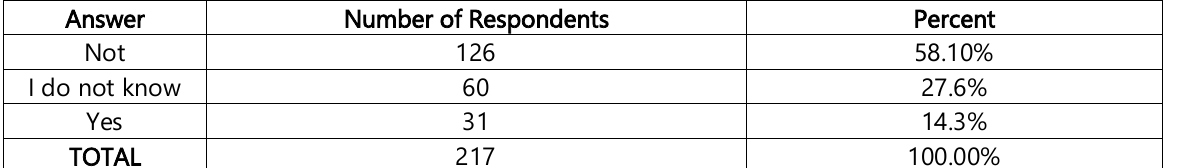
Table 3: Reflection of the Perception of the Size of the Interactions (Source: Authors’ calculation)